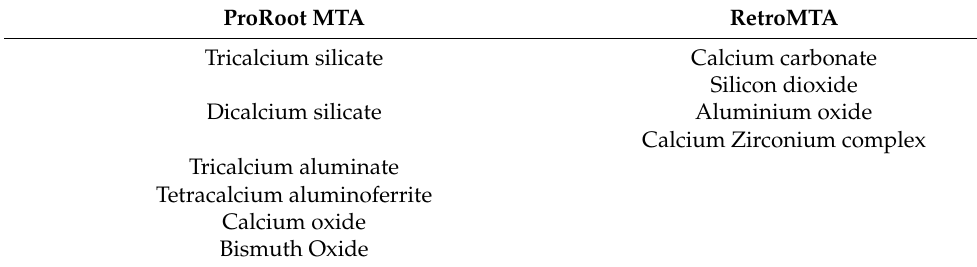
Table 1. Composition of the experimental MTA cements